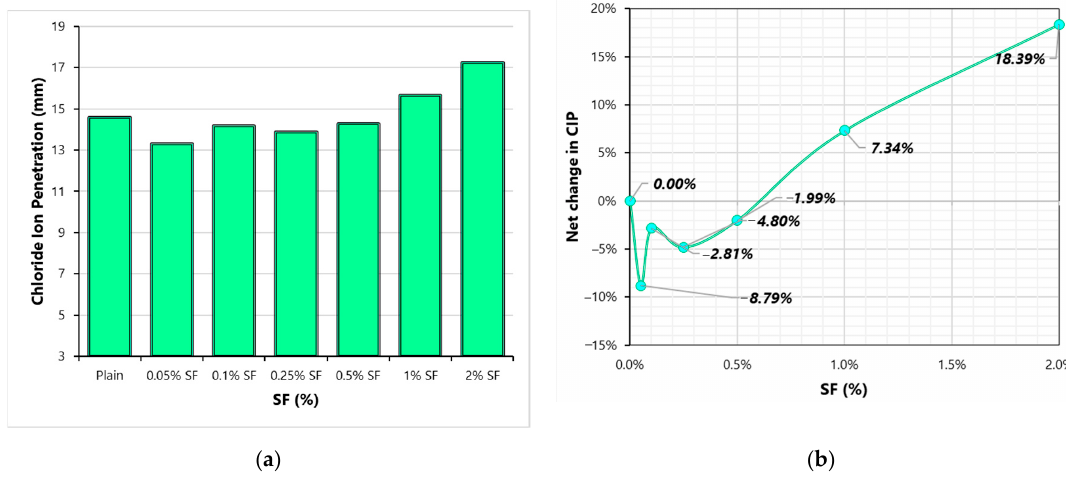
Figure 13. Chloride-ion penetration (CIP) results ( a ) Variation of CIP with SF dosage ( b ) Net change in CIP with varying SF dosage.